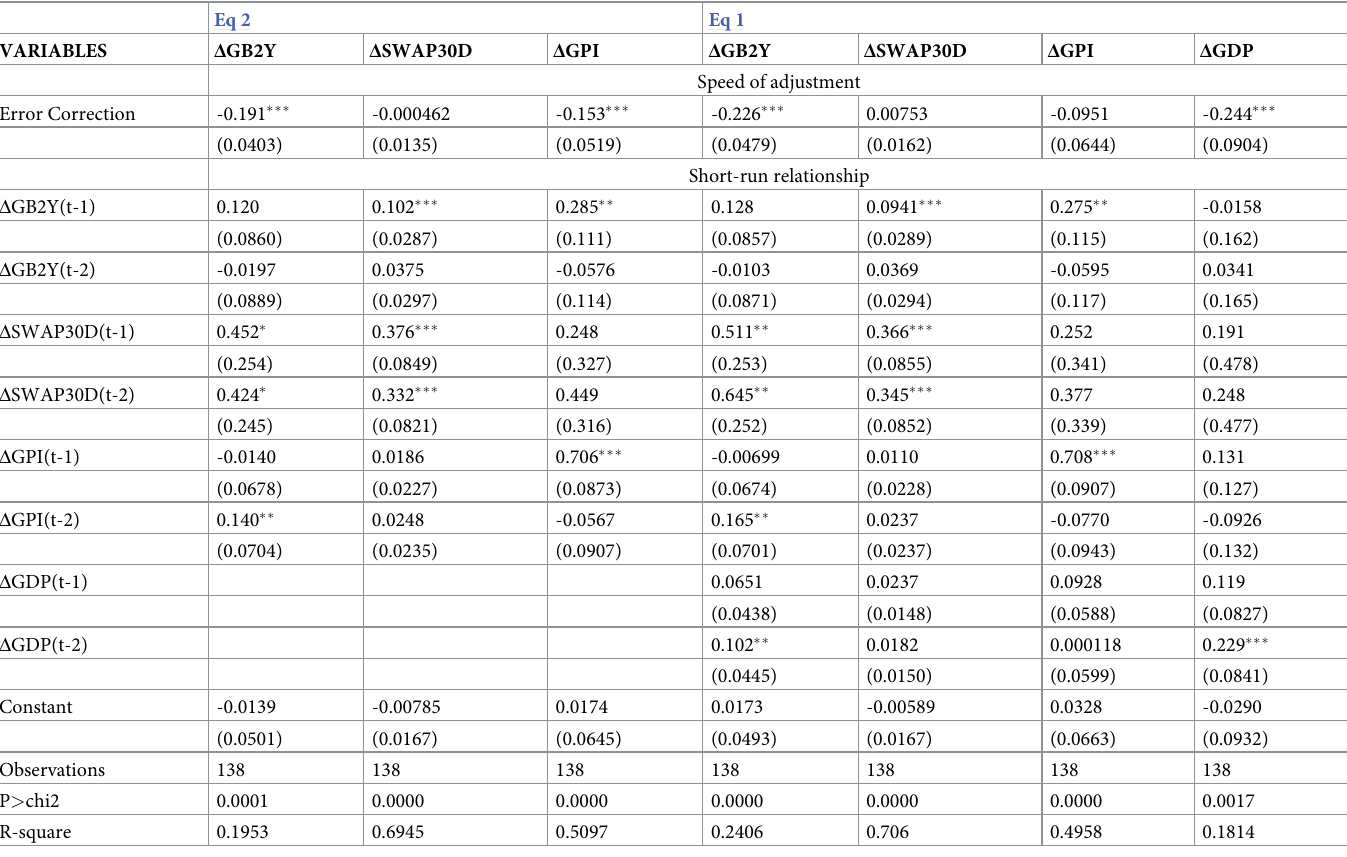
Table 4. Speed of adjustment and short-run relationship from VECM for Eq 1 and Eq